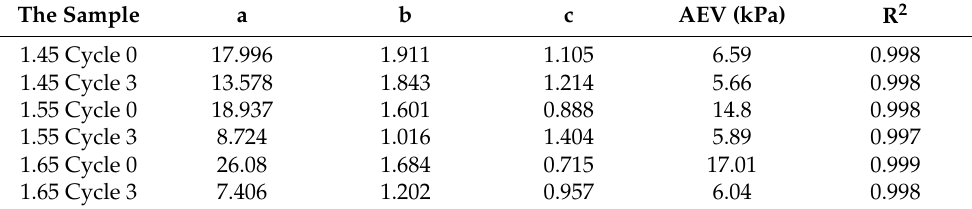
Table 2. Fitted SWCC parameters and variables from the loess